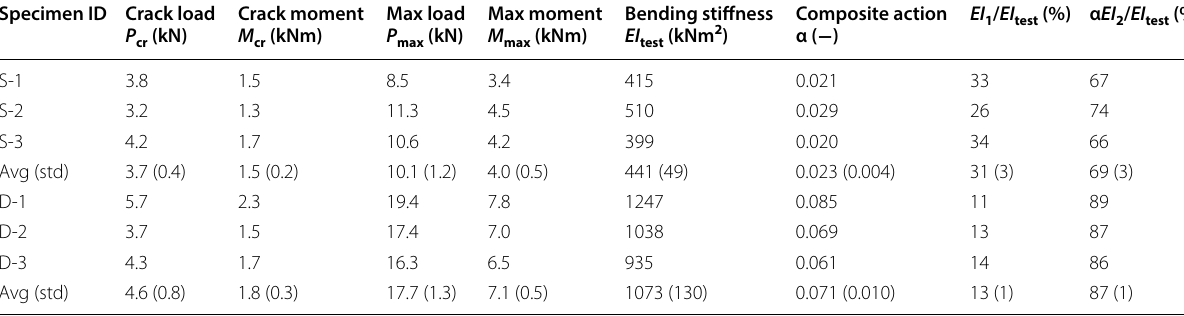
Table 2 Summary of four-point bending results for single and double connector configurations.